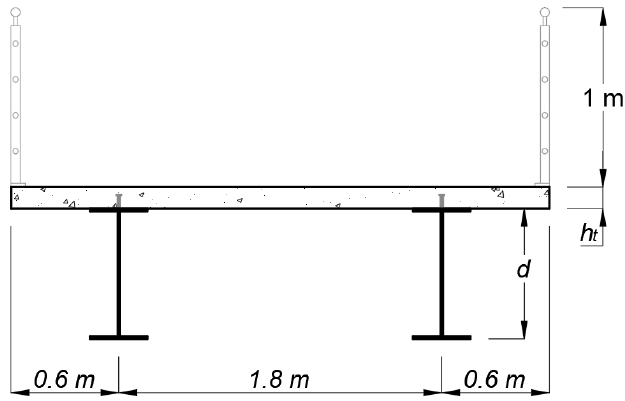
Figure 2. Pedestrian bridge cross-section.